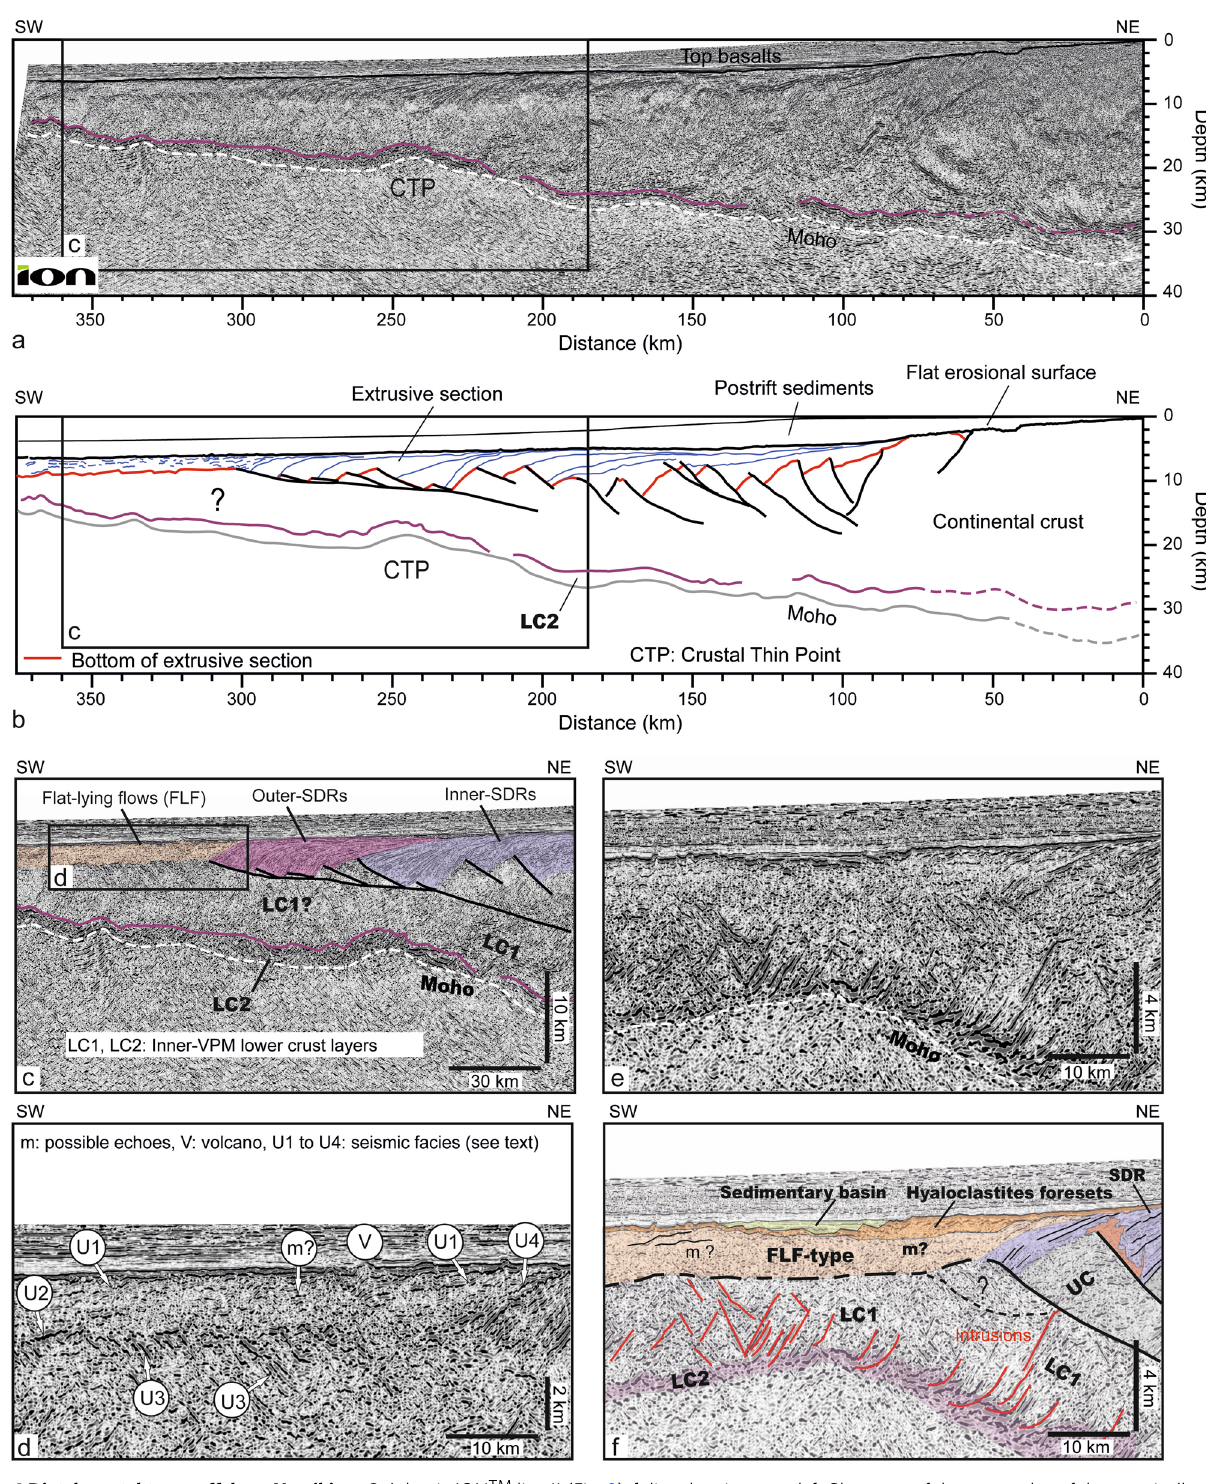
Fig. 4 Distal crustal types offshore Namibia. a S-Atlantic ION TM line II (Fig. 2); b line drawing. c and d . Close-ups of the outer edge of the margin (location in a , location of d in c ; V volcano); e , f close-up of the outer edge of ION TM line VIII (Fig. 2). Some of the periodic re fl ections could be multiples (m) of the top-basement seismic horizon. An enlargement of Figs. 4d and 4e is given in Supplementary Fig. closely spaced (~6 ± 3 km) normal faults underlined by bright re fl ections, with vertical throws <800 m, all of them dipping continentward. These faults are parallel to the re fl ectors U3 (representing, probably, planar intrusions).